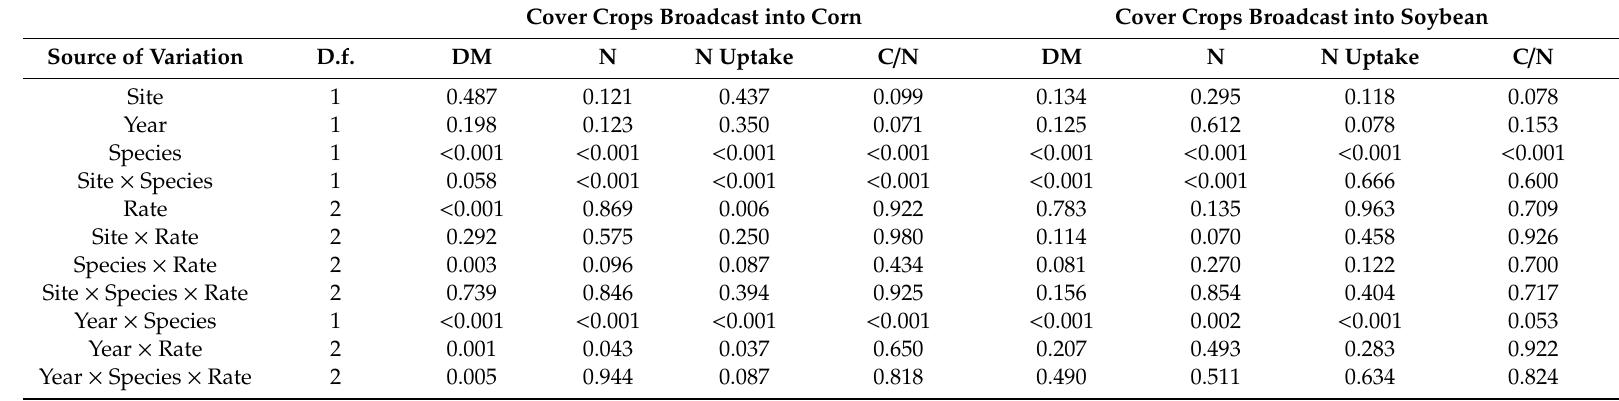
Table 5. Source of variation, and degrees of freedom (d.f.) and p -values for biomass parameters of cover crops broadcast interseeded into corn and cover crops broadcast interseeded into soybean. Variables were site, year, cover crop species, and cover crop seeding rate. Parameters were biomass (DM, kg · ha − 1 ), biomass